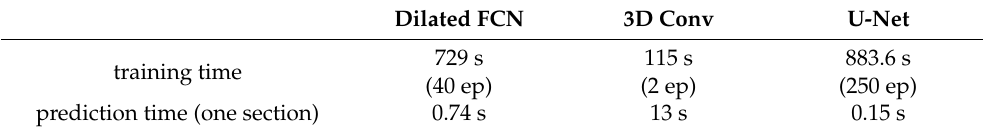
Table 6. Performance of architectures used measured with a Tesla V100-PCIE 32GB